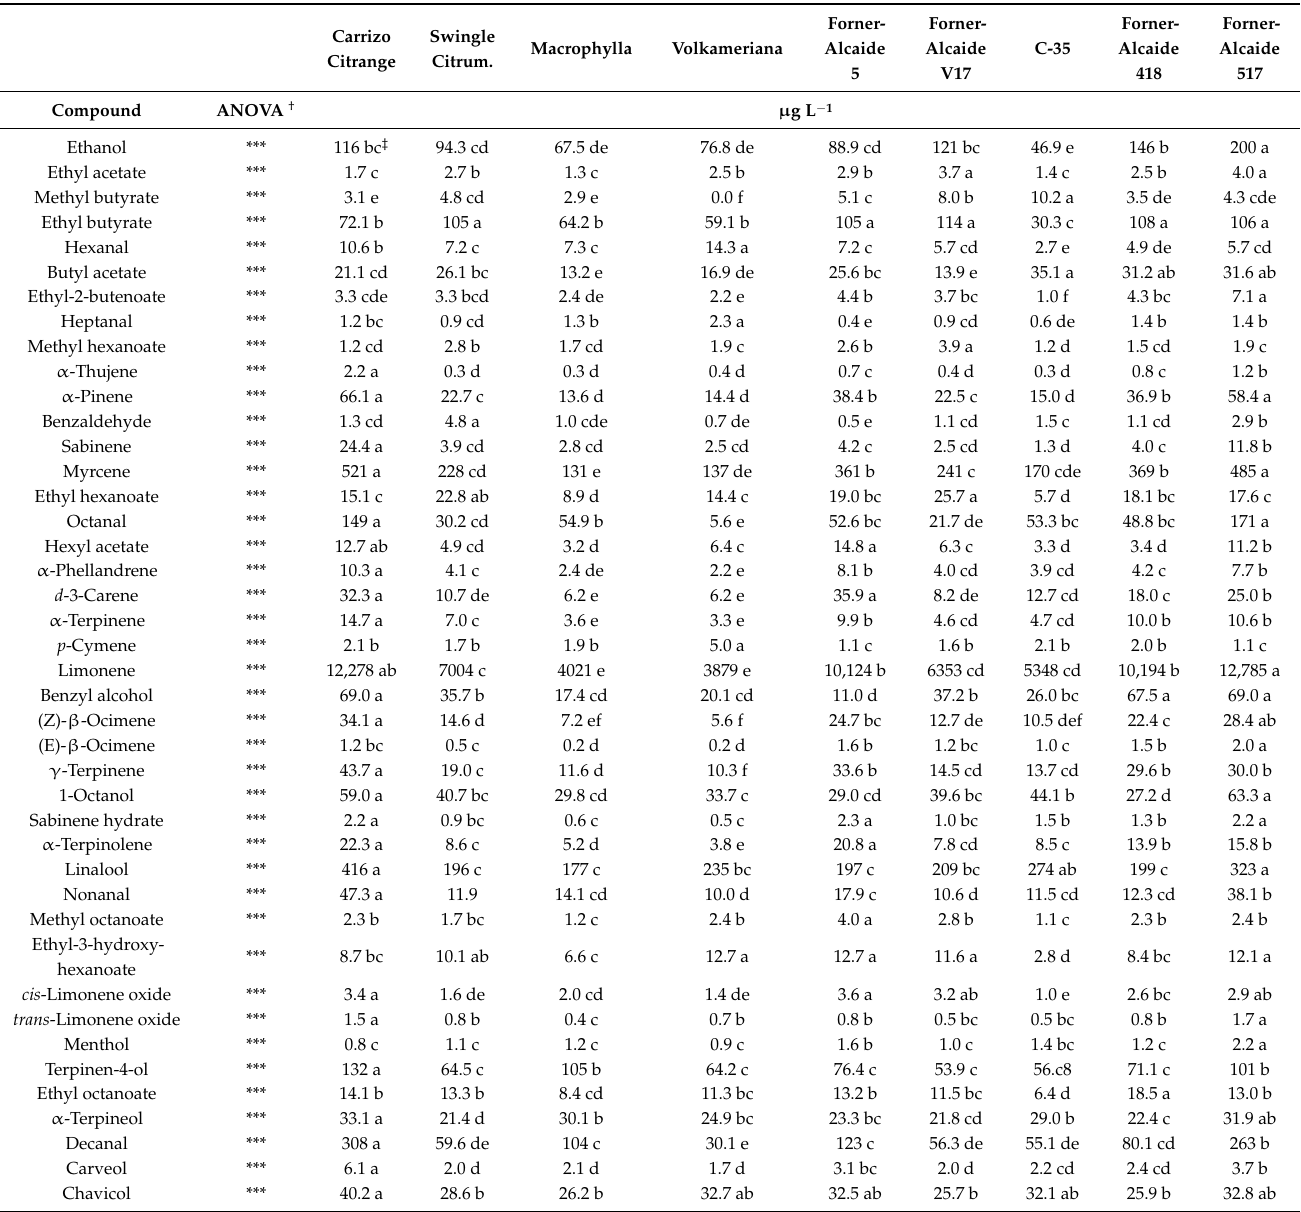
Table 3. Concentrations ( µ g L − 1 ) of volatile compounds in “Clemenules” mandarin ( Citrus clementina Hort. ex Tan.)